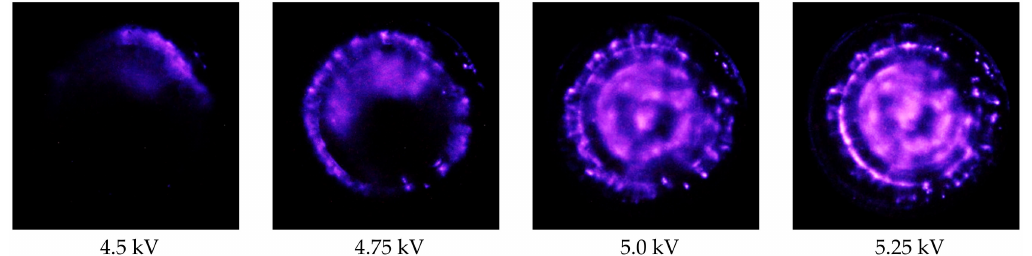
Figure 1. Spatial distribution of DBD developing in a lens-like 1.1 mm high and 16 mm in diameter air gap formed in 2.1 mm thick polyethylene terephthalate polyethylene terephthalate (PET) body at various 100 Hz AC supply voltages (peak